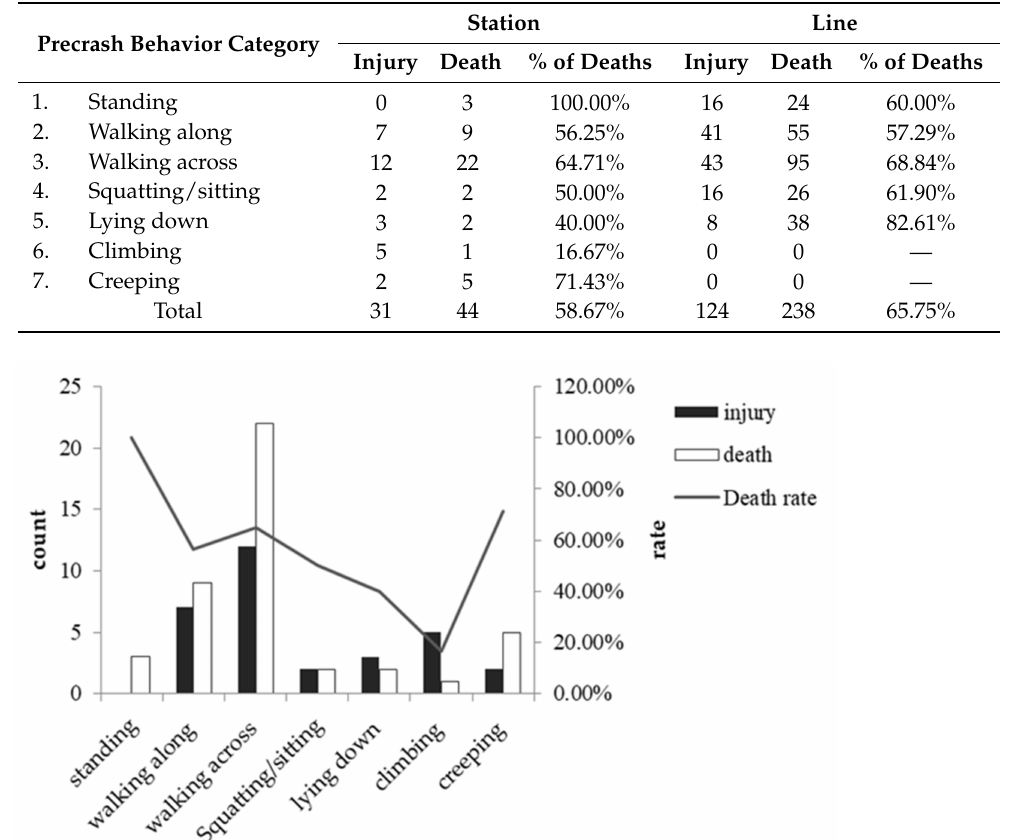
Table 8. Collision fatality rates by location and behavior.